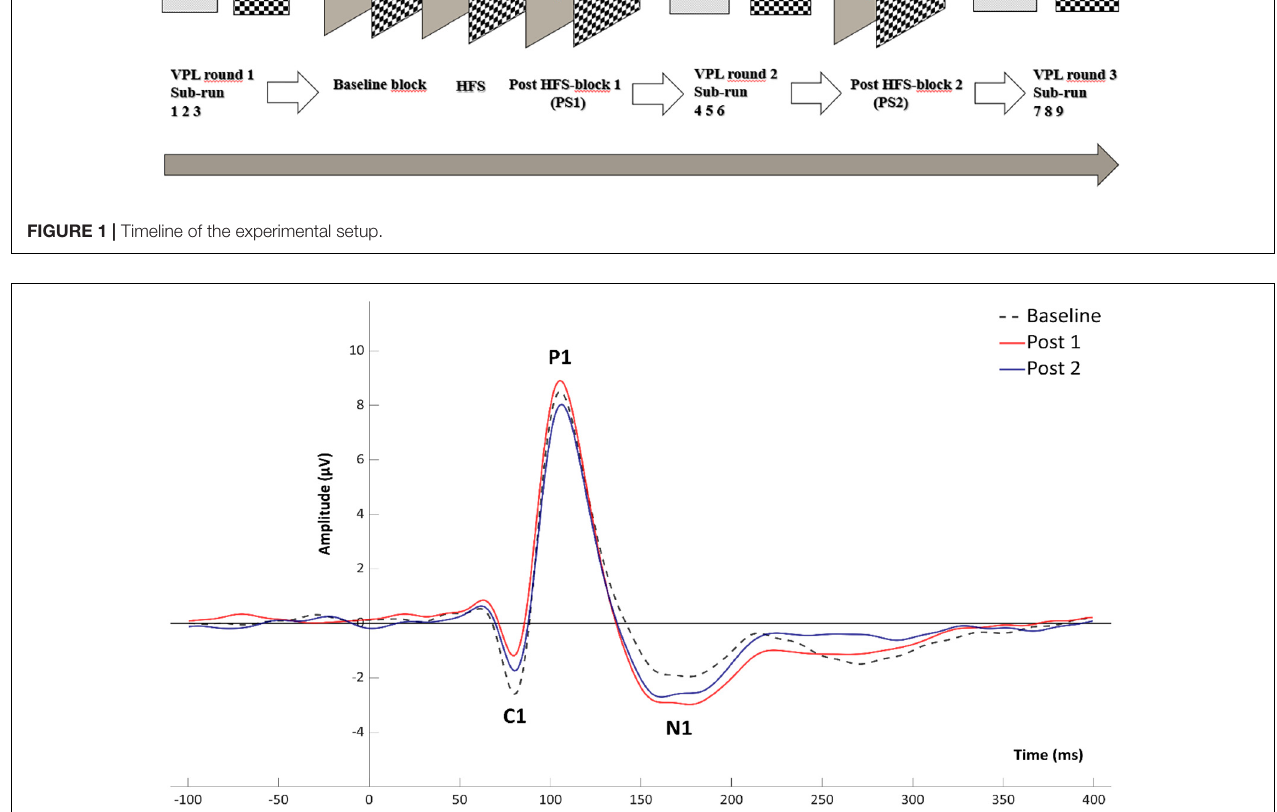
FIGURE 2 | Mean amplitudes for VEP components C1, P1, and N1 at baseline and following